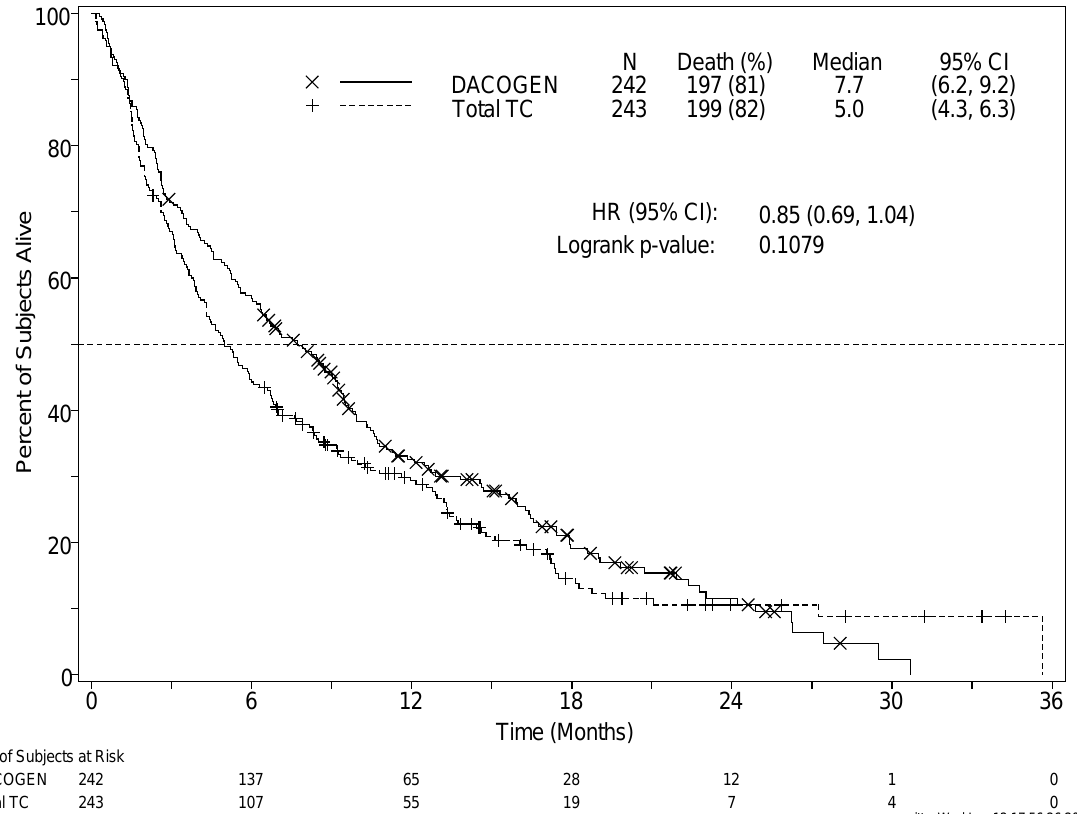
Figure 3: Overall Survival (Study DACO-016: Intent-to-Treat Analysis